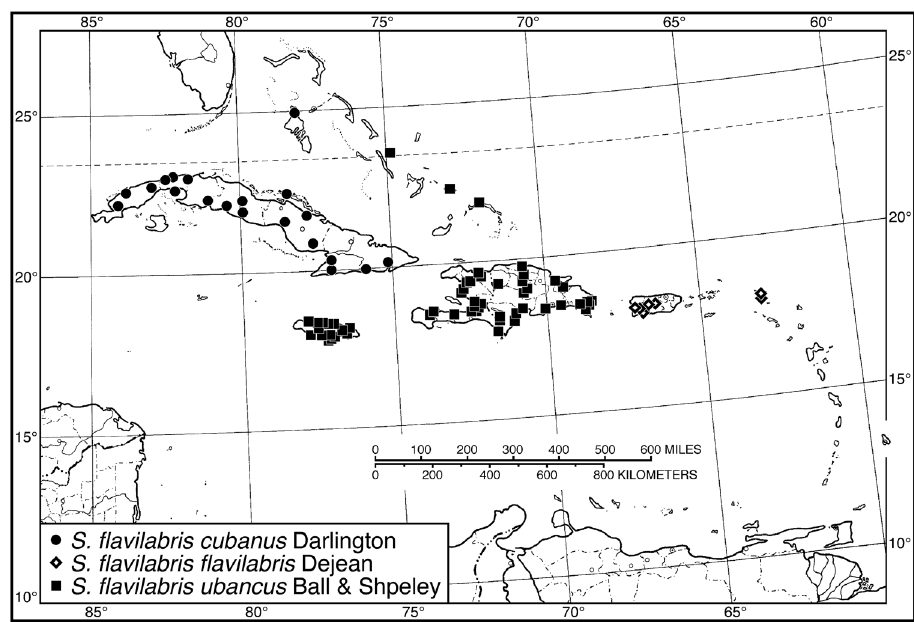
Figure 46. Map of West Indies showing known localities for species of Selenophorus opalinus species group, in part.